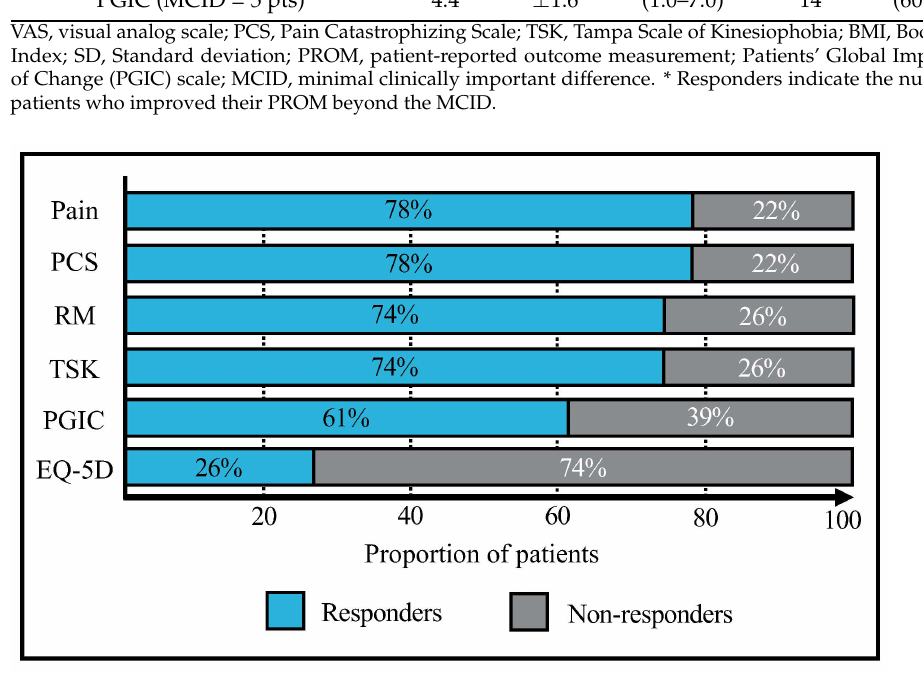
Figure 3. Bar chart illustrating the proportion of responders for different